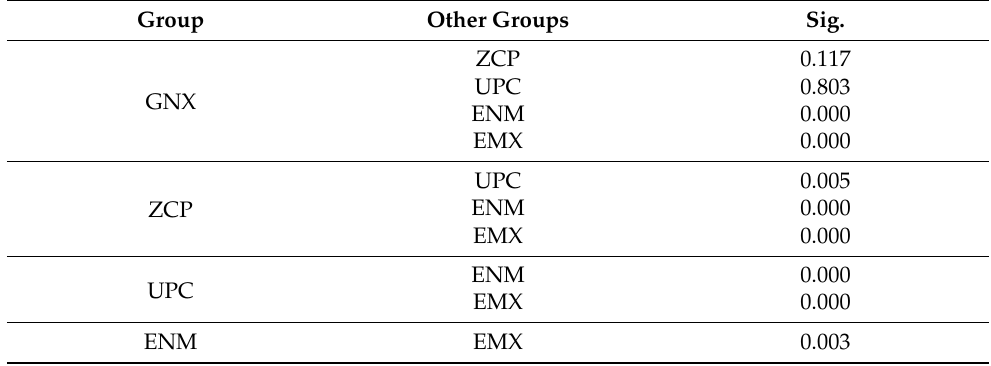
Table 8. Multiple comparisons between TP values for the aged groups. Shaded cells indicate significant differences p < 0.5.